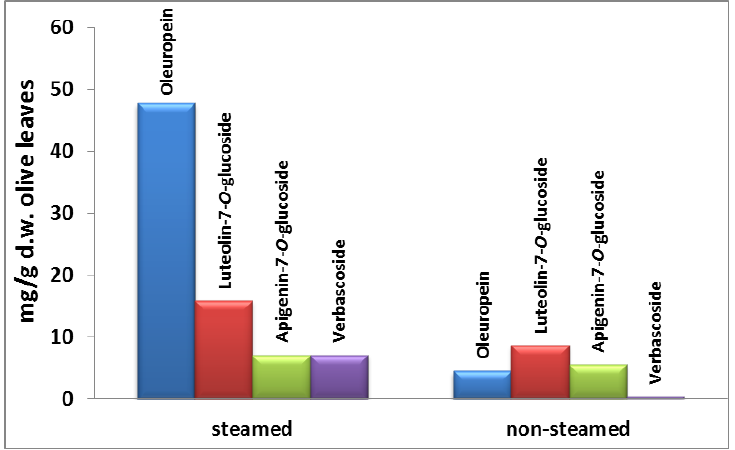
Figure 4. Total extraction yields of the main polyphenols which were determined in OL extract of steamed and non-steamed OL with HPLC-DAD after conventional extraction (70% ethanol, 48 h under stirring 400 rpm at 40 °C).